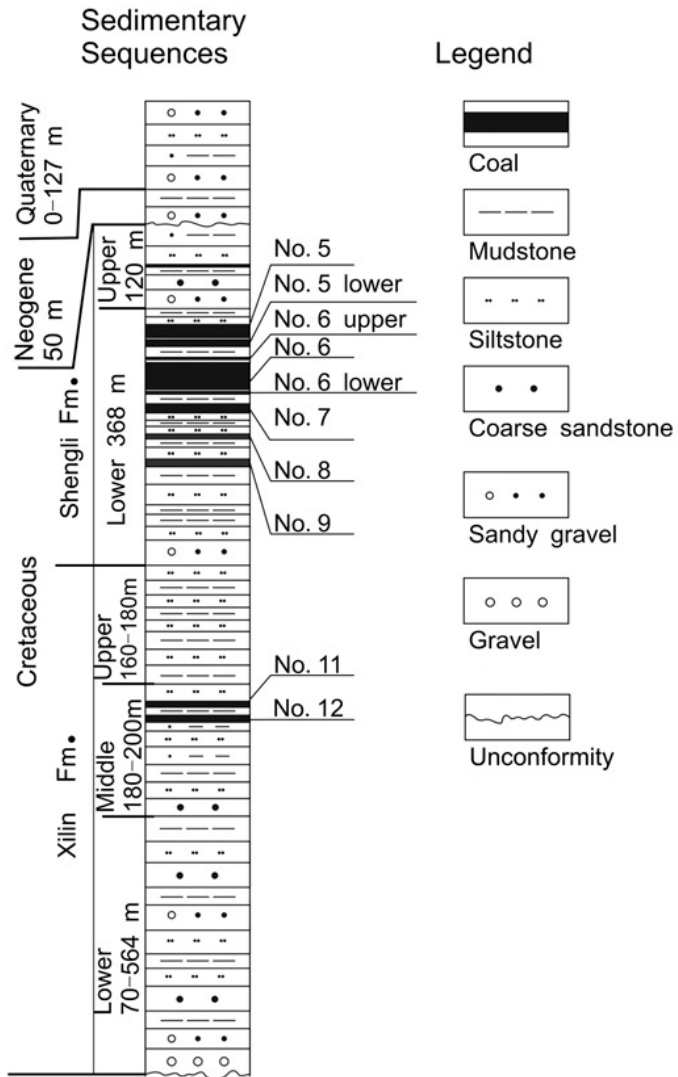
Figure 2. The sedimentary sequence of the High-Ge Wulantuga deposit [9].